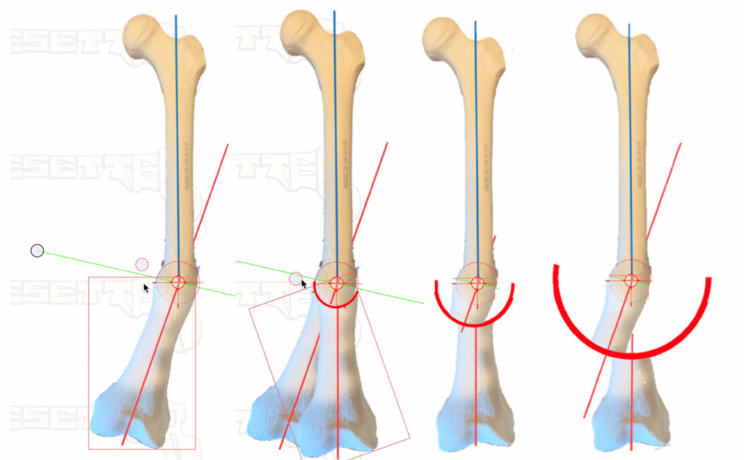
Figure 4. Limits of the arc of rotation for a focal dome osteotomy. When choosing increasing radii centered around the same CORA, the axial alignment will still be corrected equally in all three examples, though the remaining contact area decreases while the residual local diaphyseal deformity increases. With pure angulation deformities, the optimum radius is the smallest possible to accommodate the width of the bone at the level of the